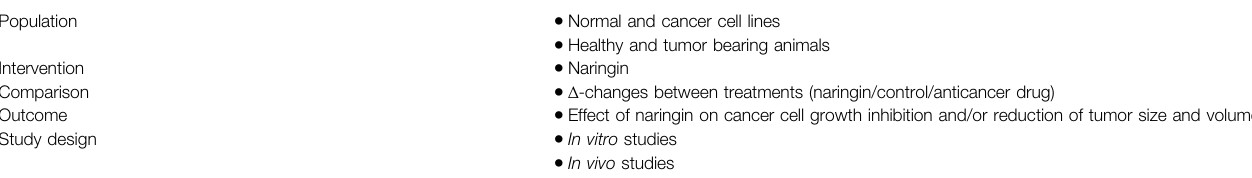
(cid:129) Healthy and tumor bearing animals